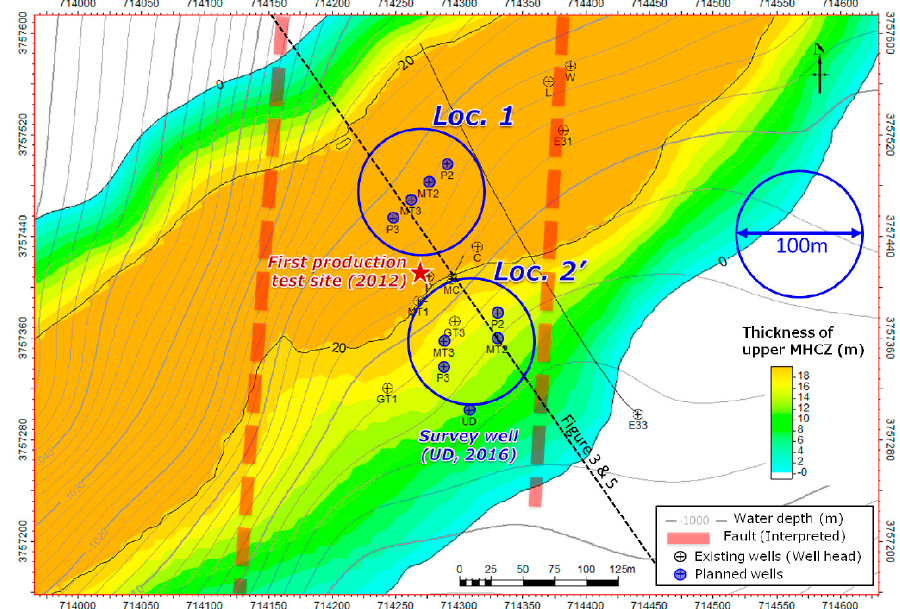
Figure 4. Candidate locations for the second production test (planned) (modified from [6]). The colored area shows the thickness of the upper MHCZ (Unit IV-1 and Unit IV-2 within the methane hydrate-concentrated zone).